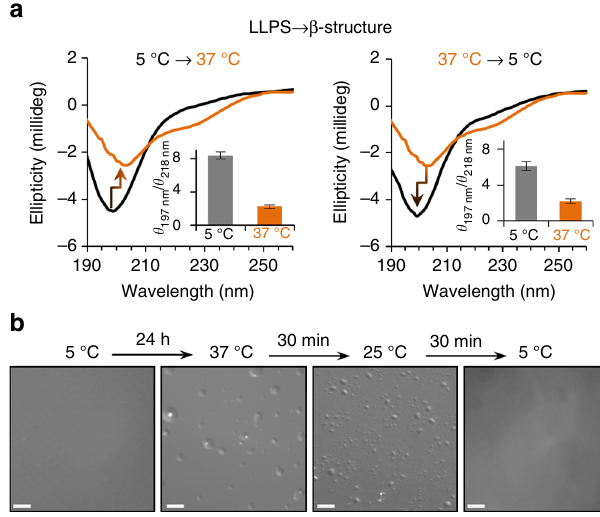
Fig. 4 K18 phase separation is reversible. CD spectroscopy ( a ) and DIC microscopy ( b ) of K18 at 5 °C (dispersed monomer) and 37 °C (LLPS), and after return to 5 °C. Scale bars correspond to 10 μ m. In a , error bars represent SEM of fi ve